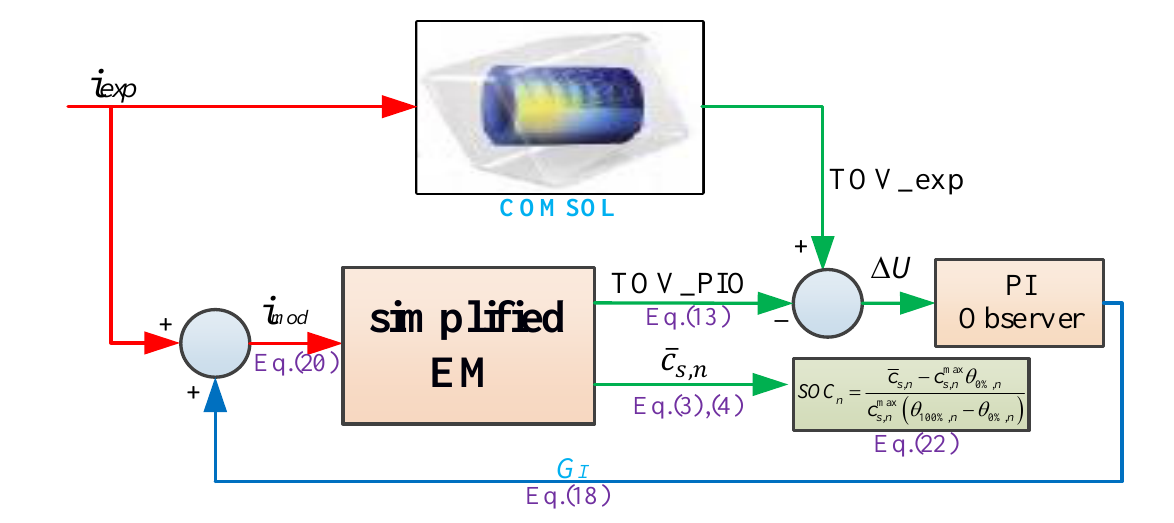
Figure 2. Framework of the proposed SOC estimation.